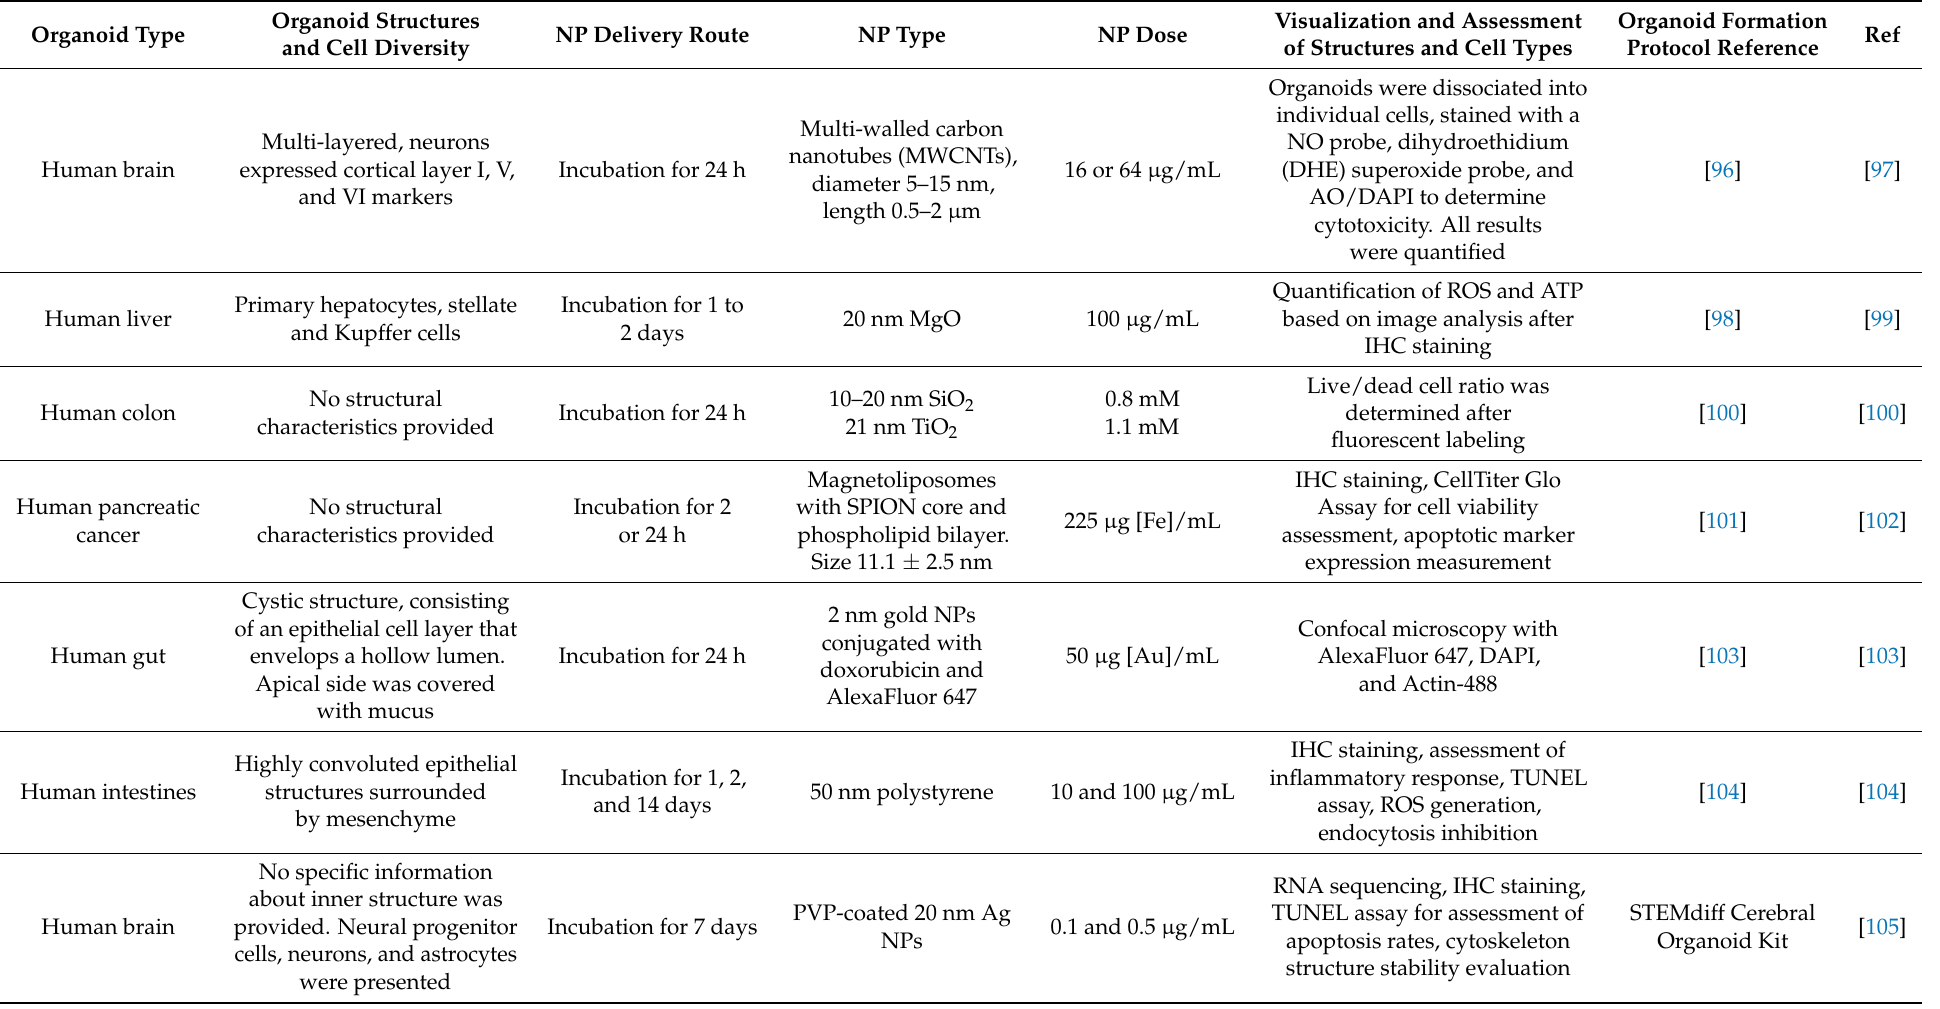
Table 4. Morphological studies of organoids in nanotoxicological studies in